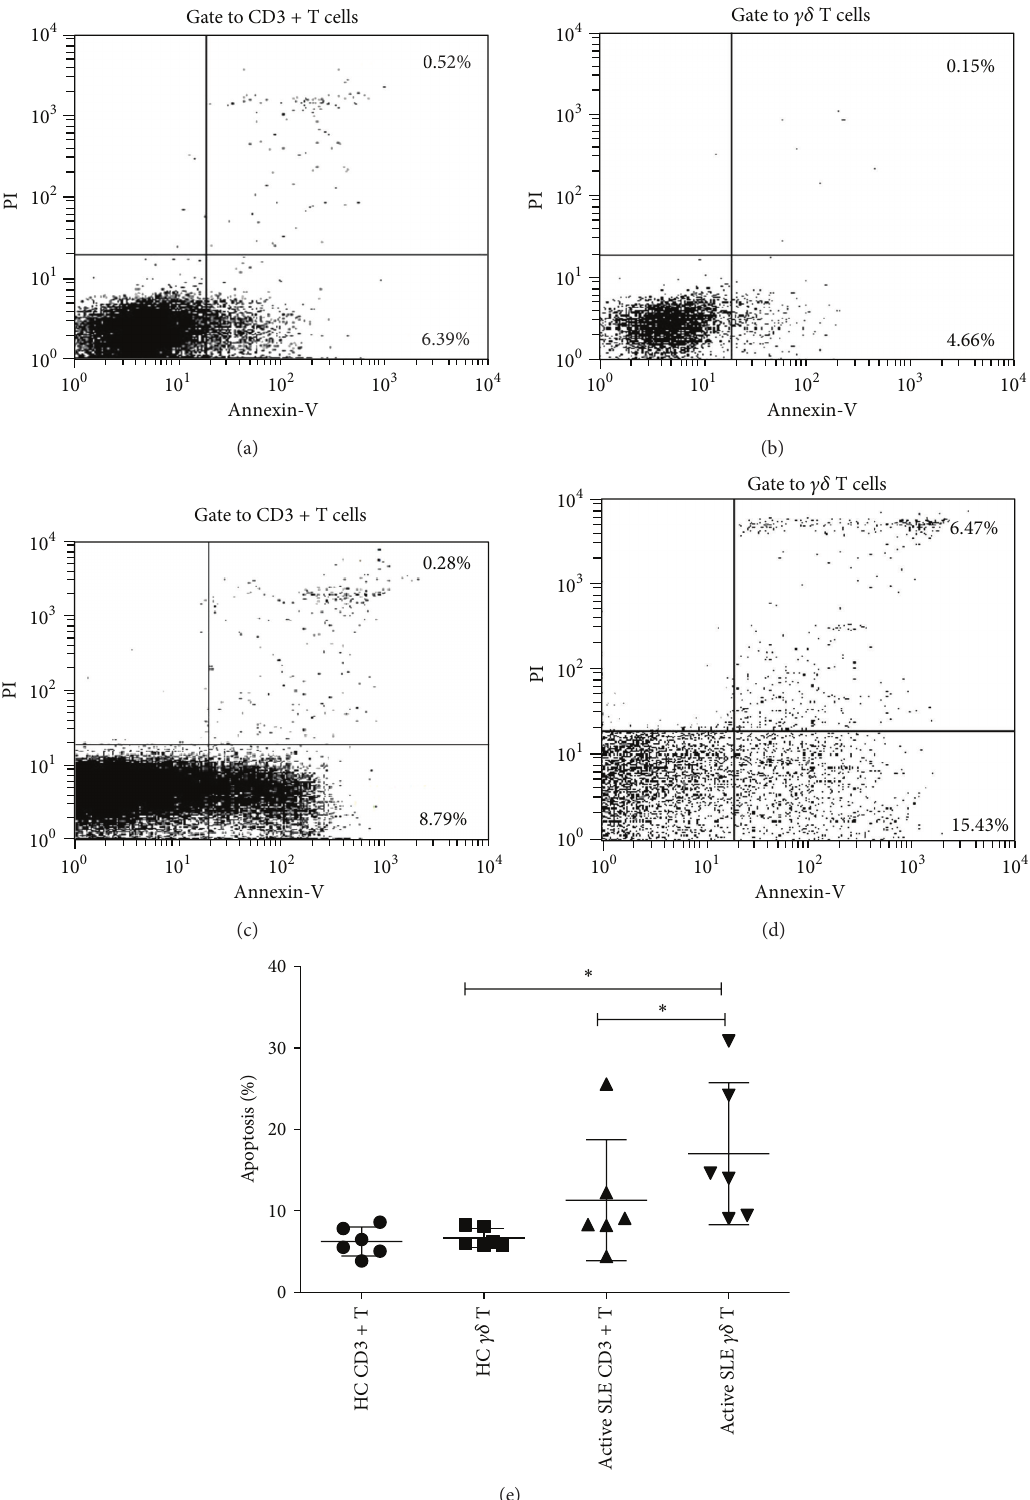
Figure 3: Increased apoptosis of peripheral 𝛾𝛿 T cells in active SLE patients. (a) and (b) Representative flow cytometric plot for apoptosis of total CD3 + T cells and 𝛾𝛿 T cells in one healthy control; (c) and (d) flow cytometric plot for apoptosis of total CD3 + T cells and 𝛾𝛿 T cells in one SLE patient; (e) comparison of apoptotic rate of CD3 + T and 𝛾𝛿 T cells between healthy controls and active SLE patients ( 𝑛 = 6 , ∗ 𝑃 < 0.05